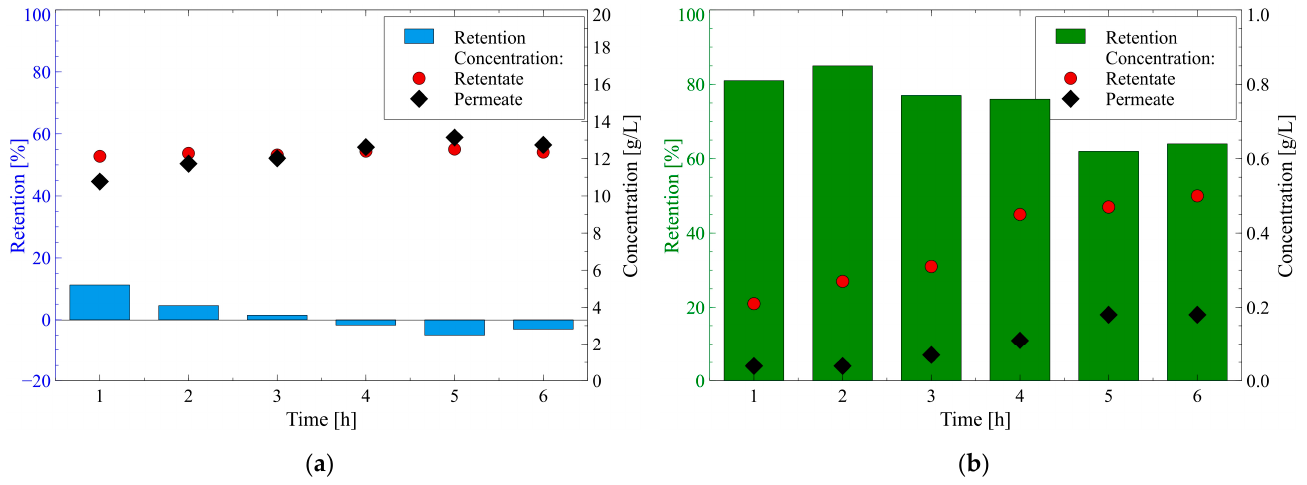
Figure 7. Changes in retention and concentration of the target product and substrate in the retentate and permeate during the NF process of fermentation broth: ( a ) 1,3-propanediol; ( b ) Glycerol. TMP = 1.4 MPa, T = 298 K.